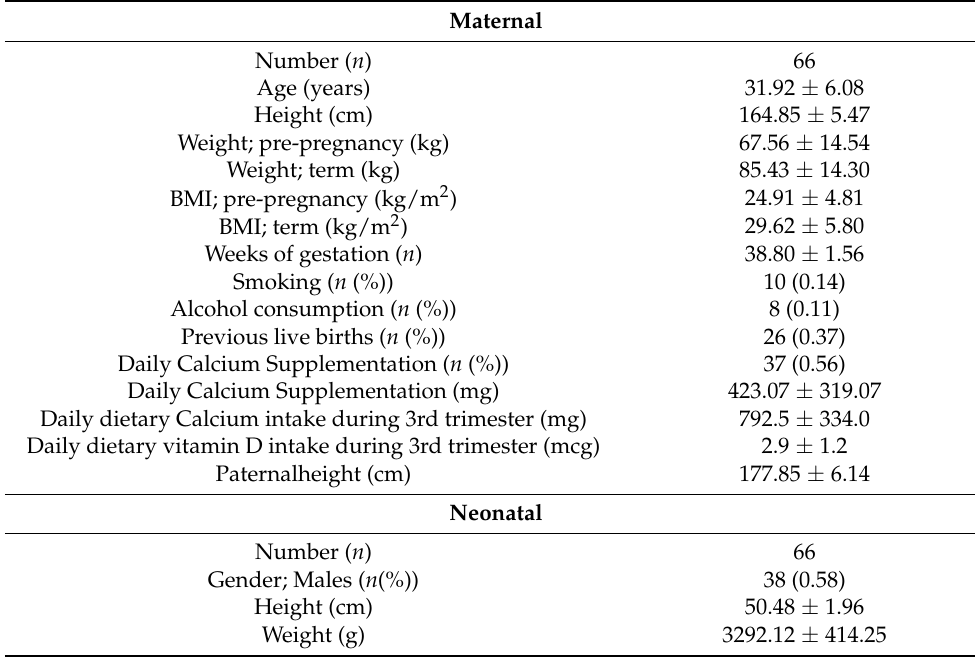
Table 1. Maternal and neonatal demographic and anthropometric